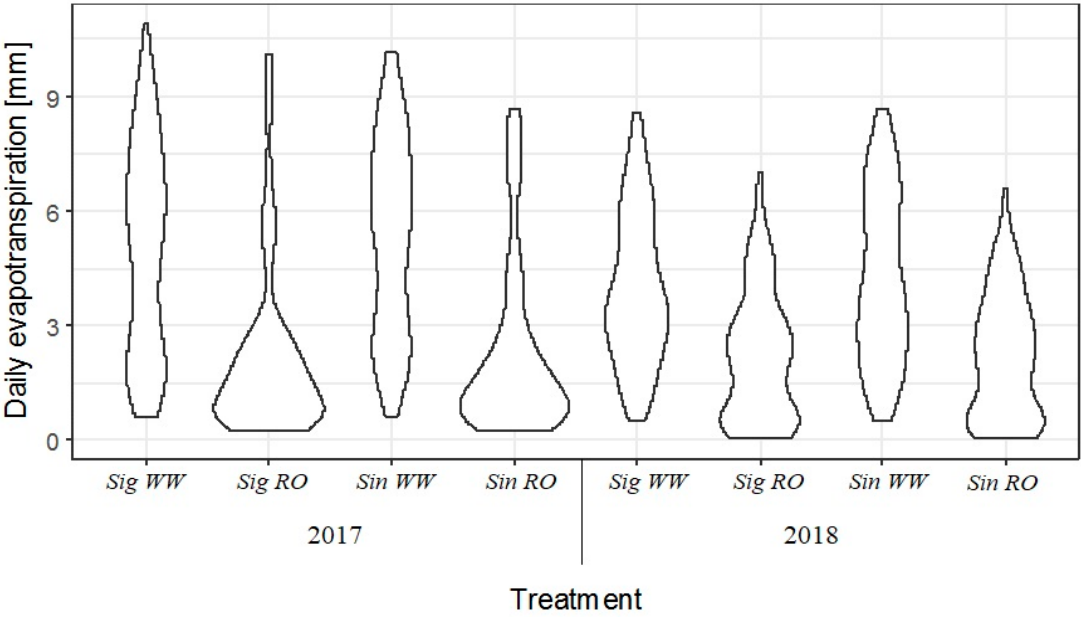
Figure 8. Distribution of the daily evapotranspiration rates ( ETR ) in two soybean varieties ( Sinara : Sin and Sigalia : Sig ) under two watering levels ( WW : unlimited water; RO : water withdrawn) of crops between 2017 and 2018.